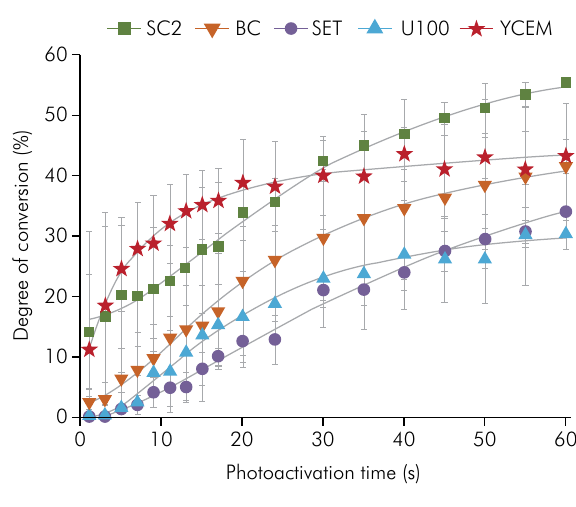
Figure 5. Degree of conversion of SARCs during photo-